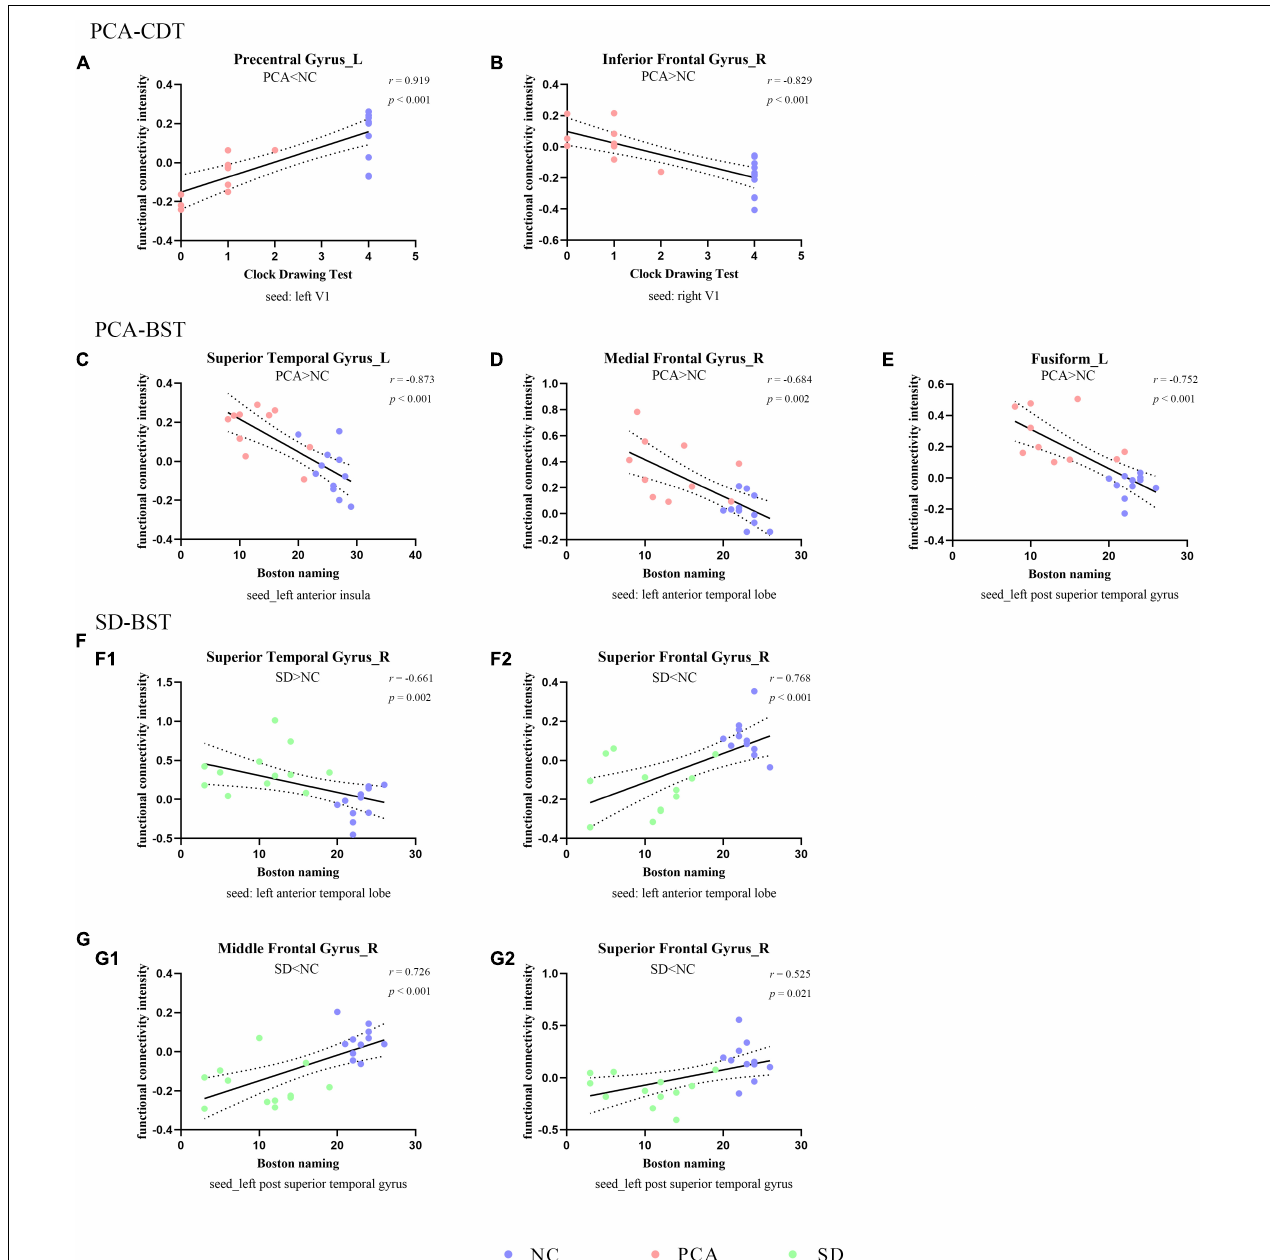
FIGURE 3 | Correlation between functional connectivity and subdomain of cognition. The scatterplots illustrate the associations between CDT (A,B) or BST (C–G) and intensity of functional connectivity in patients (PCA: A–E or SD: F–G ) and controls based on different seeds [ (A) left V1, (B) right V1, (C) left anterior insula, (D,F) left anterior temporal lobe, and (E,G) left superior temporal